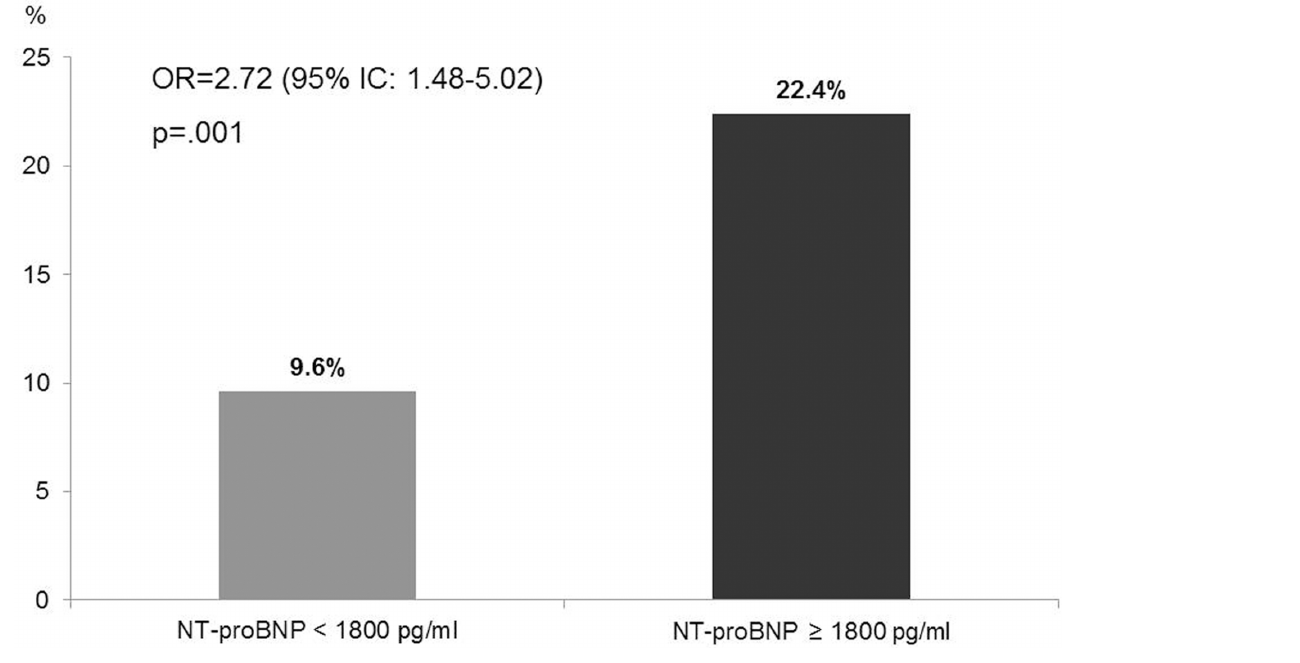
Fig 1. In-hospital mortality according to NT-proBNP levels.